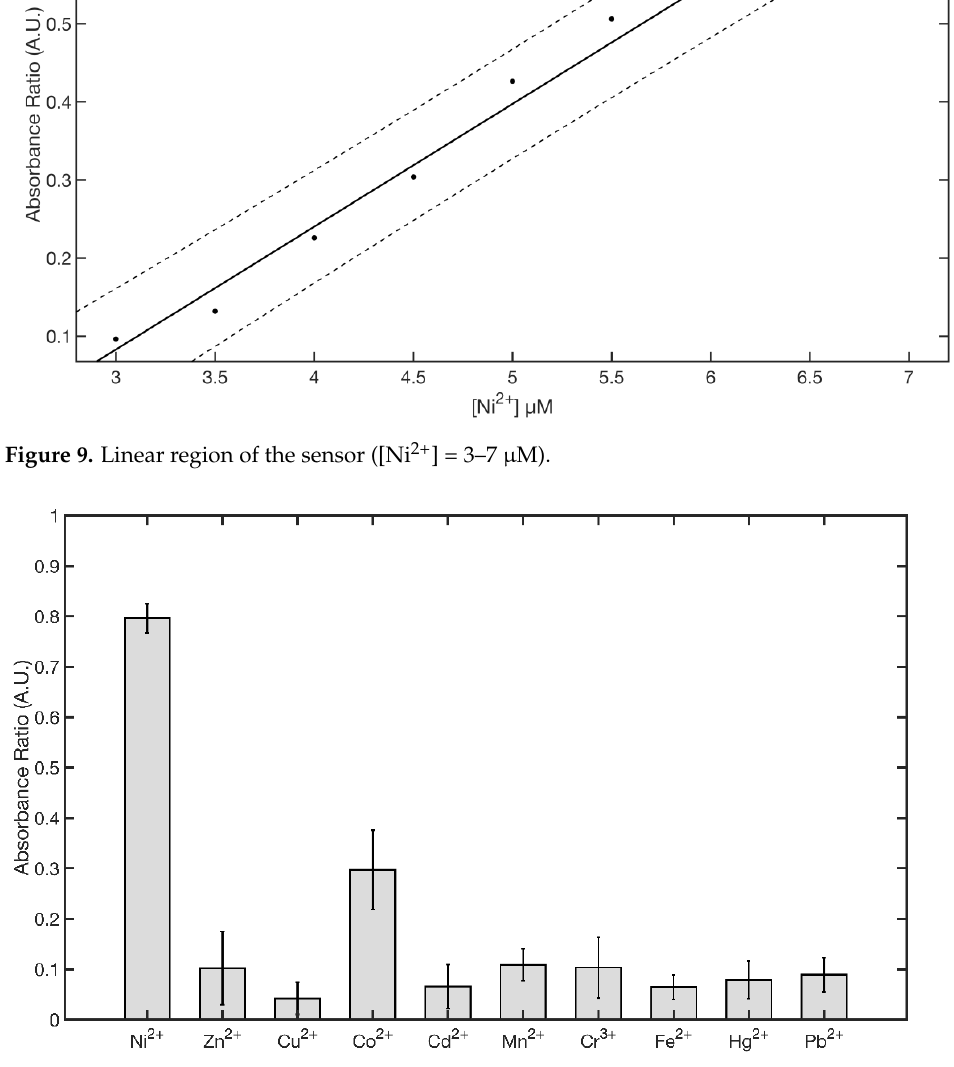
Figure 9. Linear region of the sensor ([Ni 2+ ] = 3–7 µM).